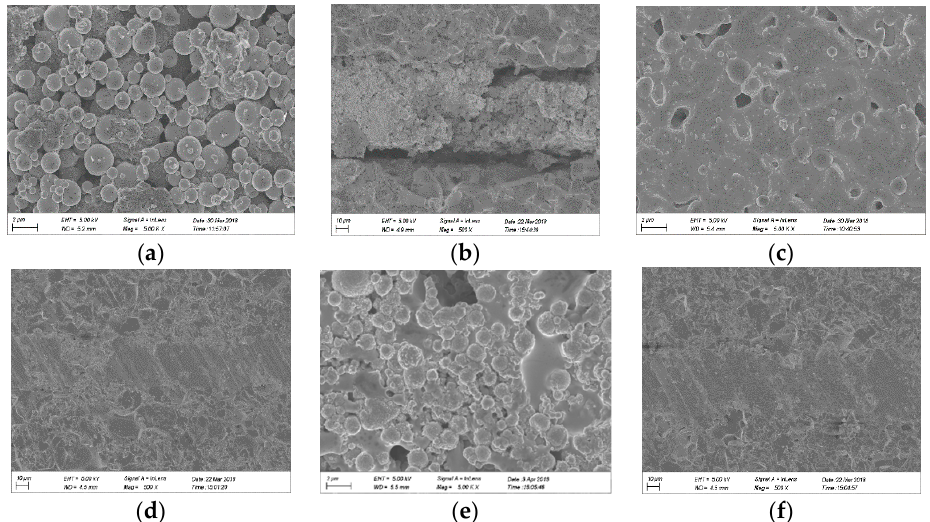
Figure 7. Micromorphology of the surface and cross-section of the A1, A3, and A5 coatings: ( a ) surface of A1; ( b ) cross-section of A1; ( c ) surface of A3; ( d ) cross-section of A3; ( e ) surface of A5; and ( f ) cross-section of A5.